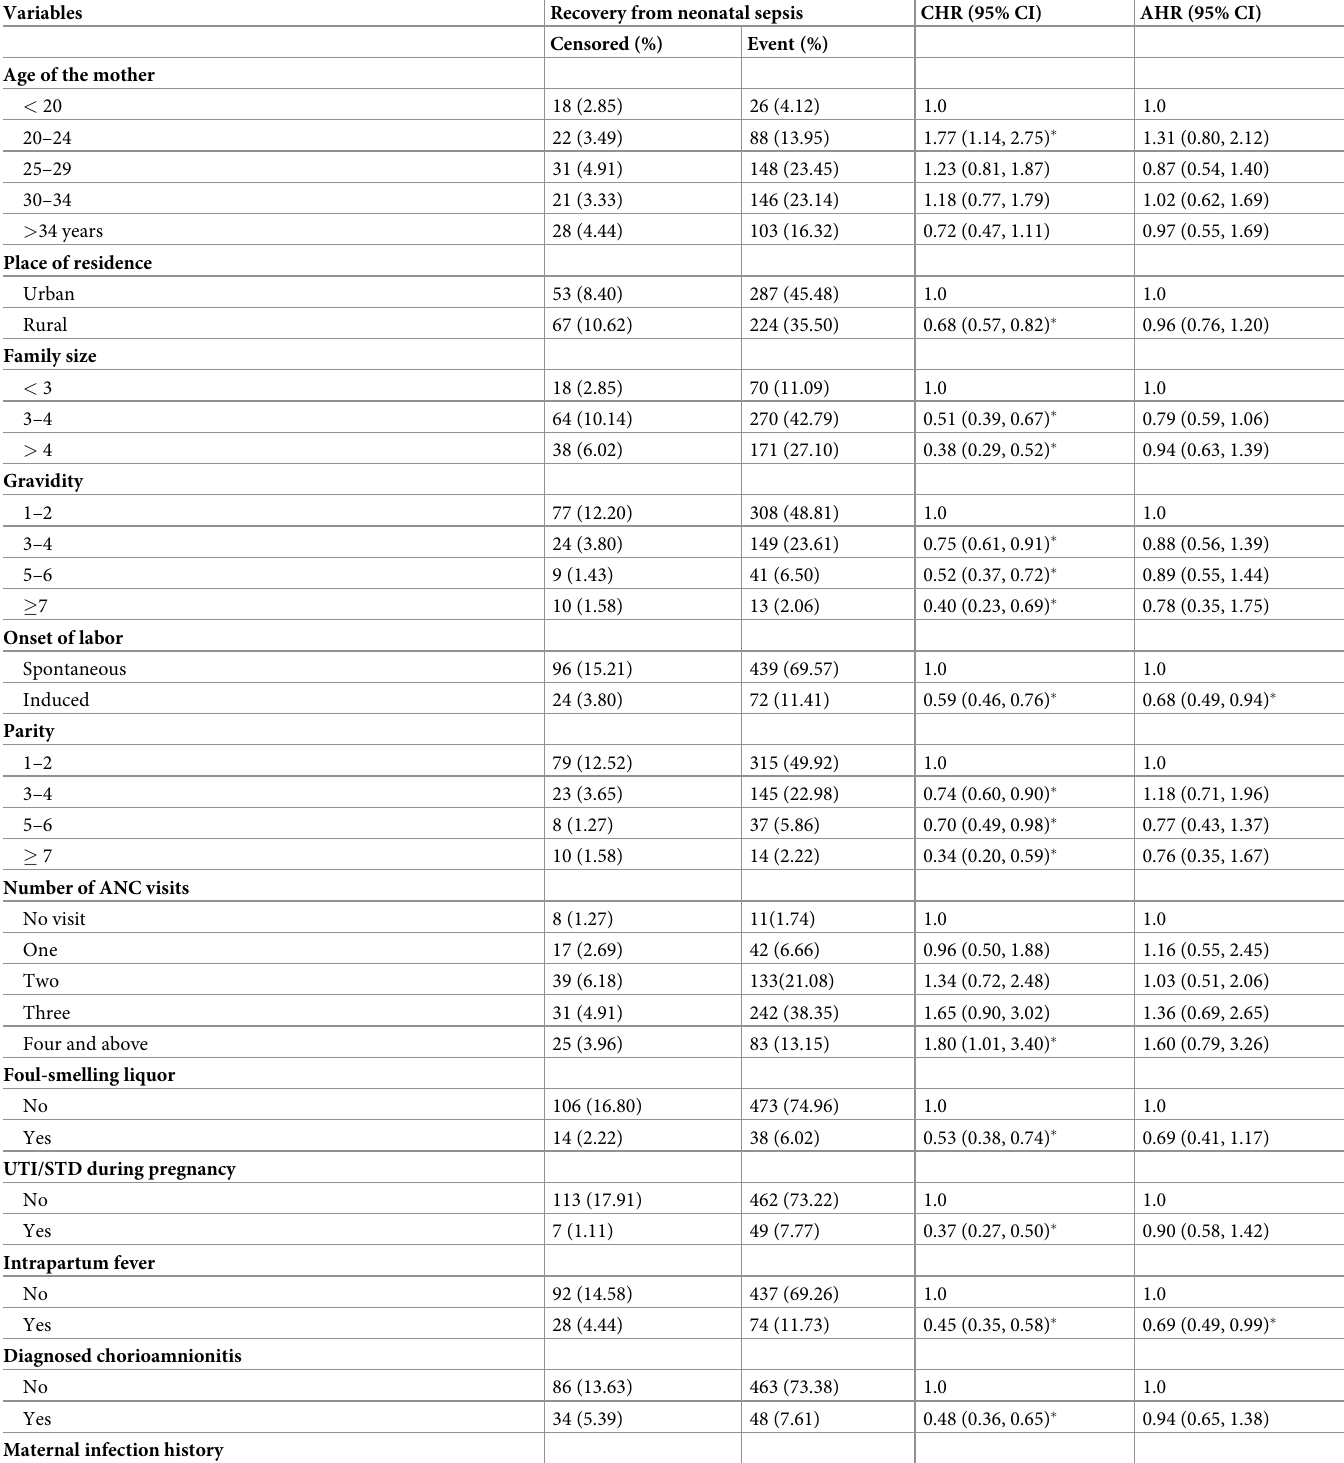
Table 7. Results of Cox regression analyses showing the association between covariates and time to recovery of neonatal sepsis in Public Hospitals of Central Gon- dar Zone,